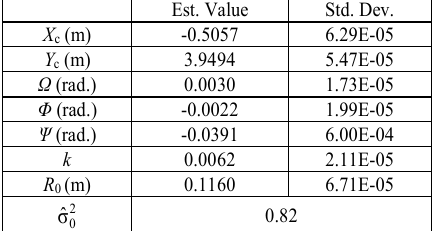
Table 2. Summary of the real data fitting Pole